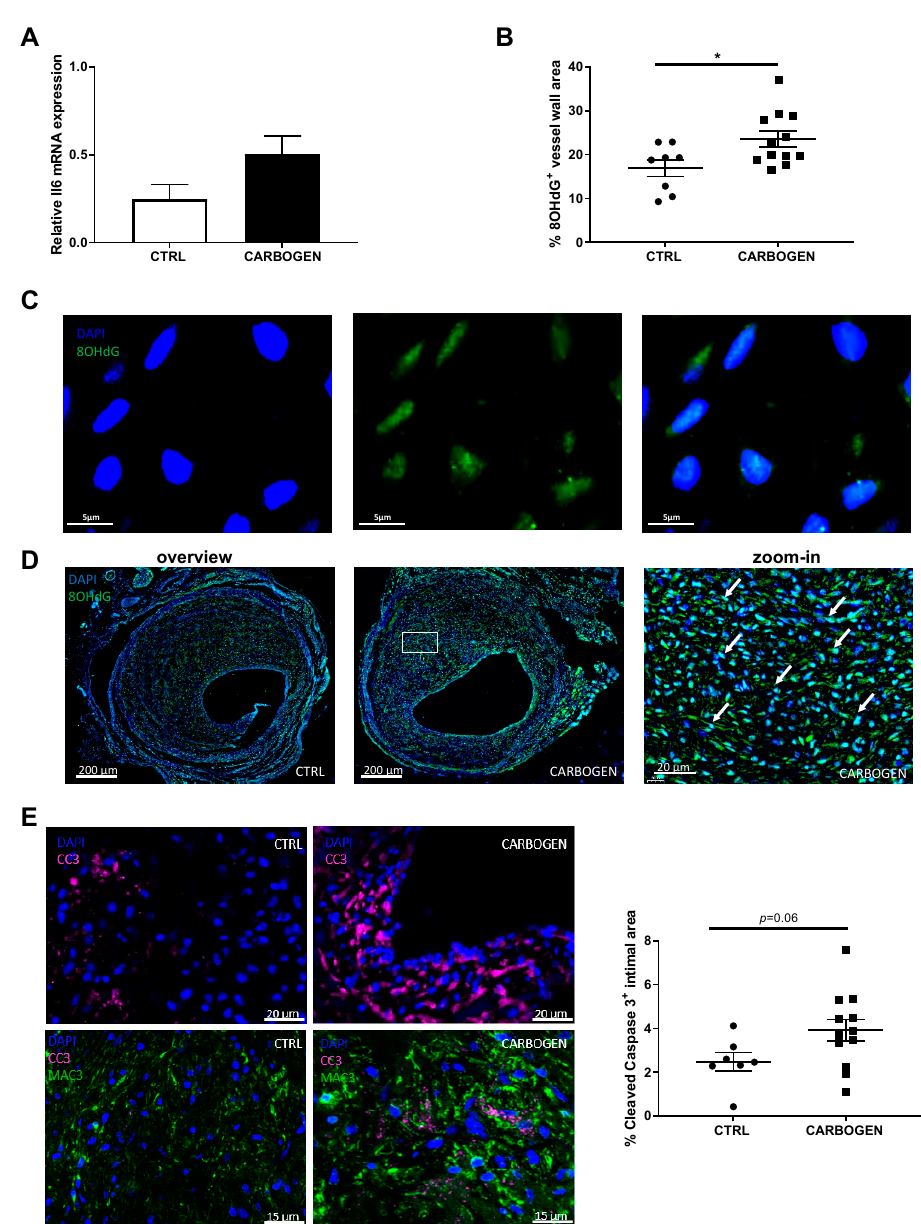
Figure 6. Chronic carbogen treatment induces accumulation of ROS. ( A ) Il6 gene expression relative to Hprt in the total vessel wall of control and chronic carbogen treated groups. ( B ) Quantification of the percentage of vessel wall area positive for 8OHdG. ( C ) Representative pictures of DAPI (in blue, left panel), 8OHdG (in green, central panel) and merged (right panel) staining in the vein graft lesions. ( D ) representative pictures of DAPI (blue) and 8OHdG (green) staining in vein graft lesions from control ( n = 8) and carbogen treated ( n = 12) mice. Light blue staining represents nuclei positive for 8OHdG and examples are indicated by white arrows. ( E ) In the top panels, representative pictures of DAPI (blue) and cleaved caspase 3 (CC3, in magenta) staining and in the bottom panels representative pictures of DAPI (blue), CC3 (magenta) and Mac3 (green) staining in control and carbogen groups respectively. In the right panel quantification of percentage of intimal area positive for cleaved caspase 3. Data are presented as mean ± SEM. * p < 0.05 by two-sided Student’s t